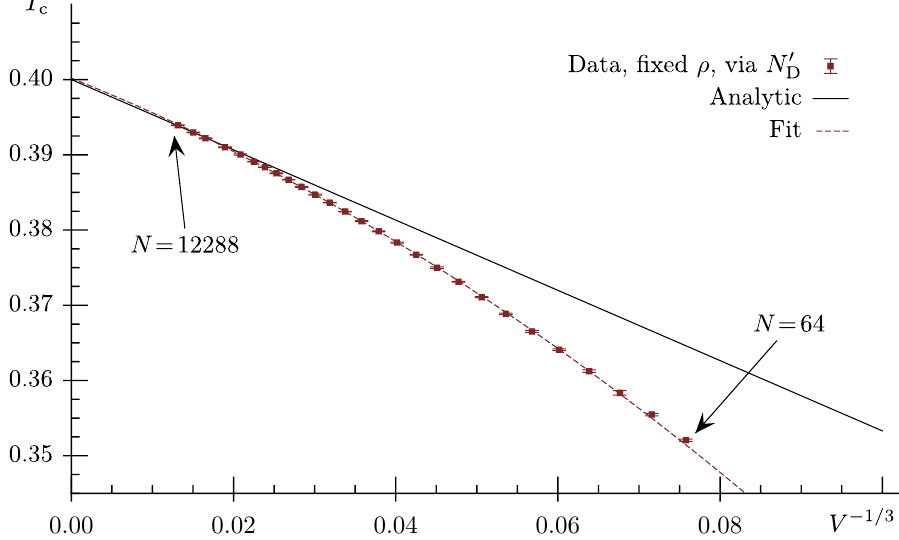
( T = 0.4 ) . The slope of the g